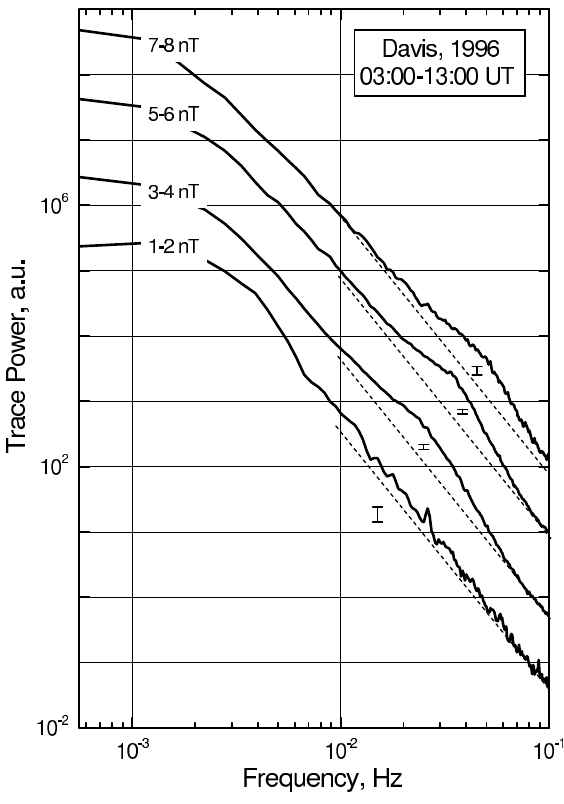
Fig. 3. Dependence of spectral shape on | B IMF | at Davis over 1996. Error bars under each curve denote respective 95%-confidence in- tervals. Dotted lines represent S ∝ f − 4